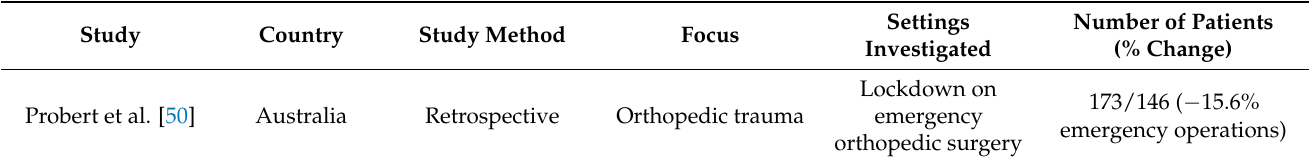
Table 7. Characteristics of relevant publications on orthopedic performance in